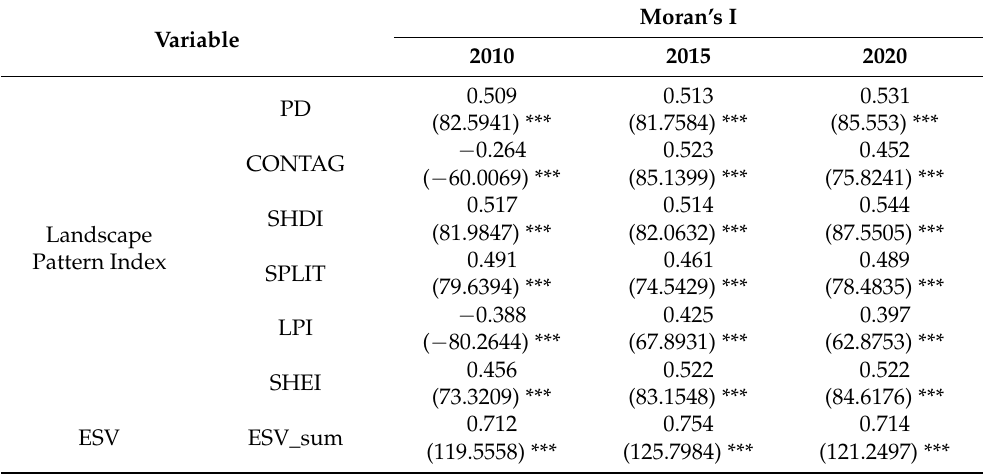
Table 5. Univariate global spatial autocorrelation analysis of landscape pattern index and